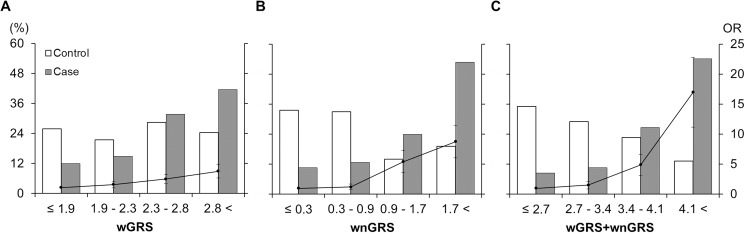
Comparison of genetic (A), nongenetic (B), genetic plus nongenetic (C) models in 142 cases and 490 controls after removing individuals with missing values from HEXA data. White and dark-gray bars (left Y-axis) denote the proportions of controls and cases, respectively, in each risk quartile. Black dots and solid lines (right Y-axis) denote odds ratios and their standard errors for each risk quartile group compared to the lowest risk quartile group (X-axis).